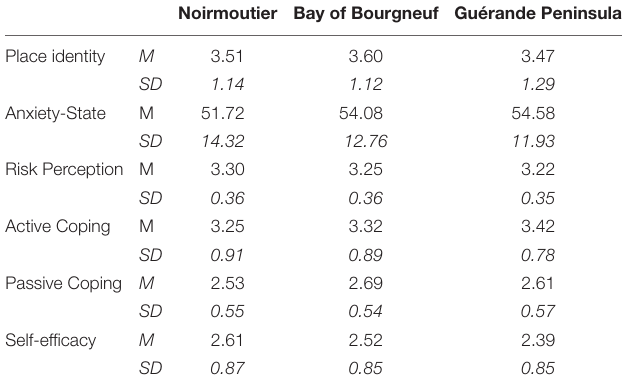
TABLE 3 | Means and standard deviation for each variables on the different sites investigated. Noirmoutier Bay of Bourgneuf Guérande